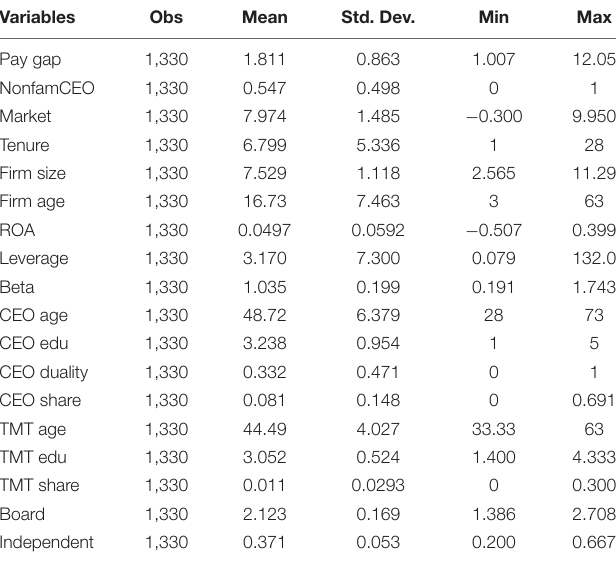
TABLE 2 | Descriptive